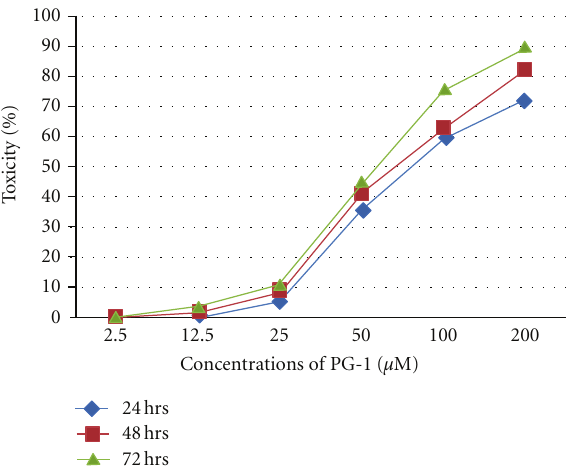
Figure 4: Maximum nontoxic dose (MNTD) of PG-1.The MK2 cell lines were seeded at 1 × 10 4 cells per well in triplicate at optimal conditions (37 ◦ C, 5% CO 2 in humidified incubator) in 96 well plates. PG-1 was diluted to serial concentrations 2.5, 12.5, 25, 50, 100, and 200 μ M with DMEM media supplemented with 2%